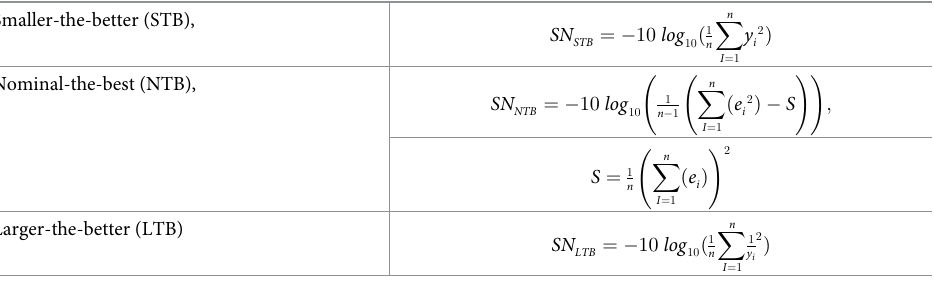
Table 2. S/N ratio according to the objective function